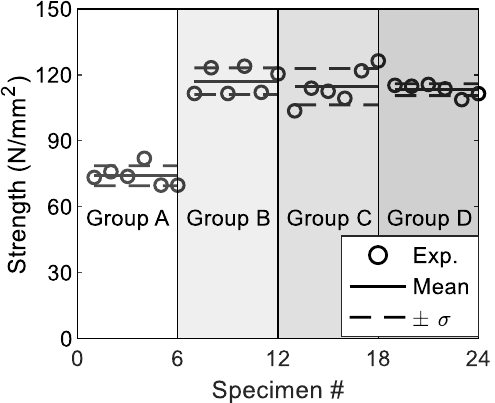
Figure 9. Compressive strength (note: σ denotes th e standard deviation).